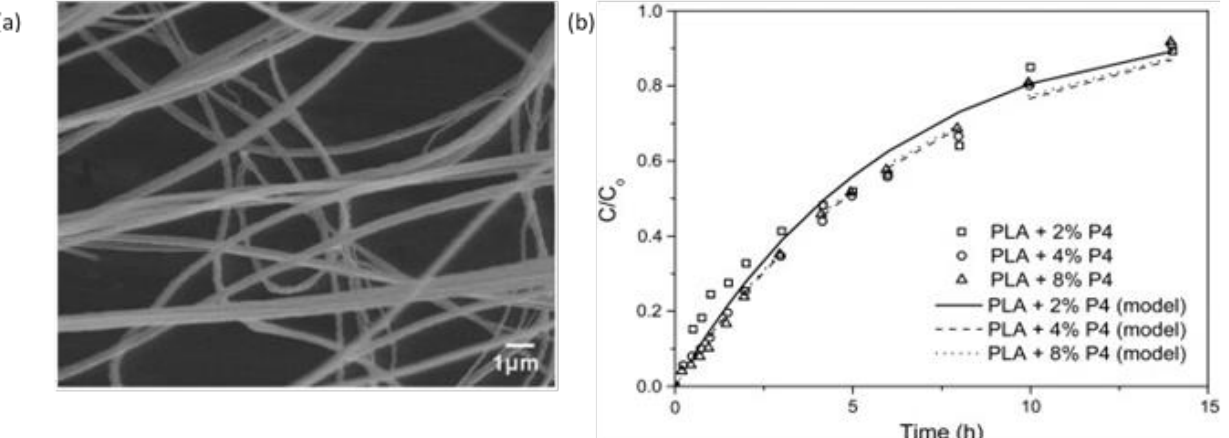
Figure 21. Fibres loaded with progesterone. ( a ) SEM images of fibres with 6% w / v PLA and proges- terone 4% w / v ( b ) Progesterone release profiles from fibres prepared from solutions containing PLA 6% w / v and 2, 4, or 8%. Reproduced with permission from [160], copyright 2013 Elsevier.